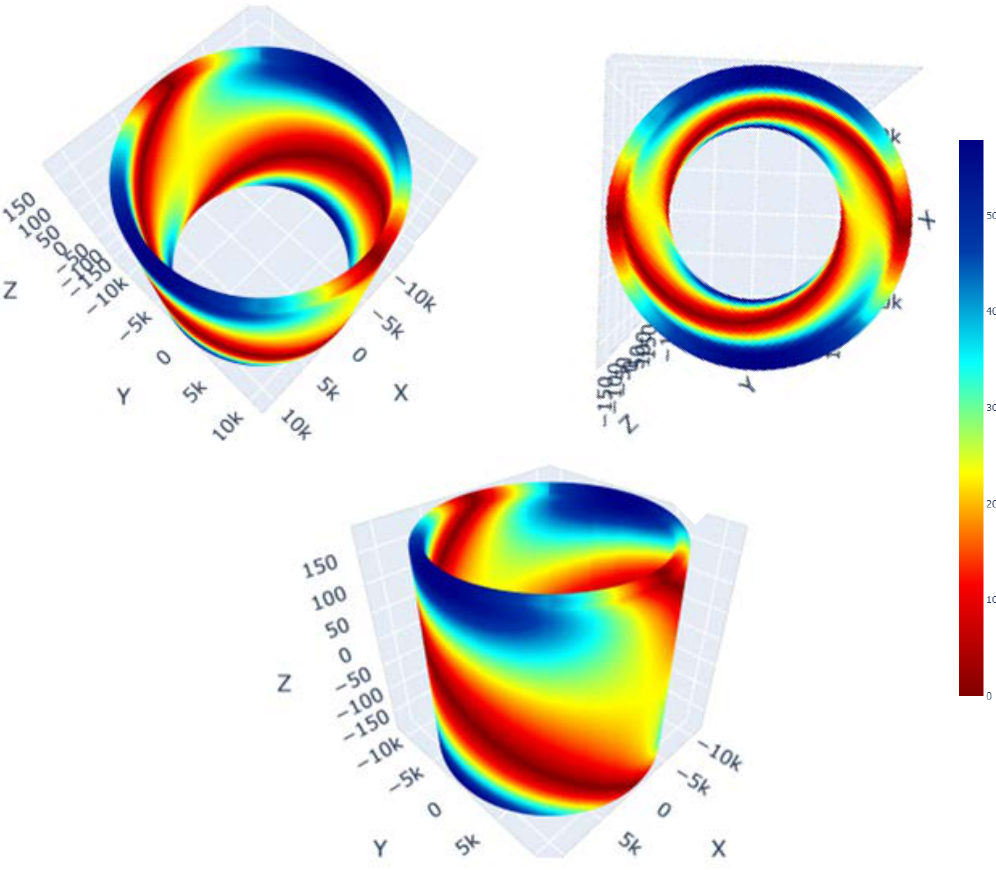
Figure 11. 3D schematic diagram of ship risk of collision.